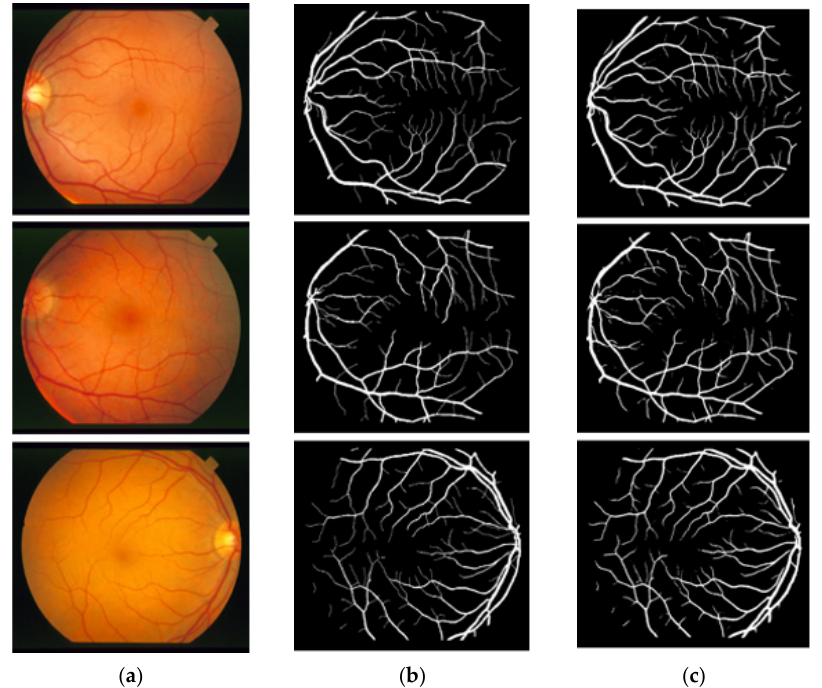
Figure 10. Visual results of the proposed DSA-Net using the STARE dataset: ( a ) Original input image, ( b ) Expert annotation, and ( c ) Predicted image mask by DSA-Net.